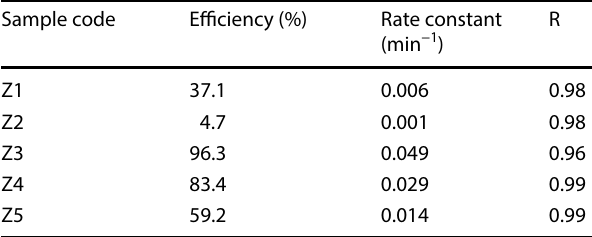
Table 3 Comparison of photodegradation efficiency of the synthe- sized photocatalysts for methyl